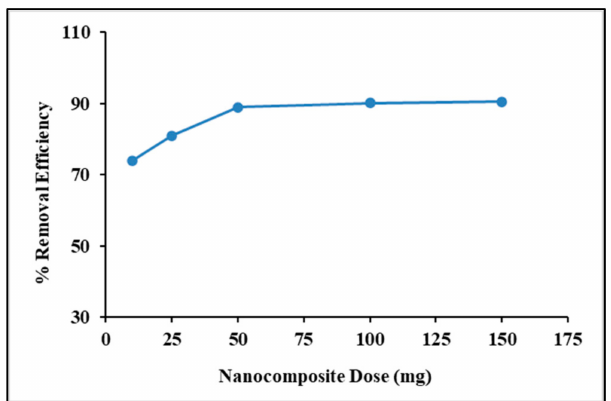
Figure 10. Effect of adsorbent doses on MB removal